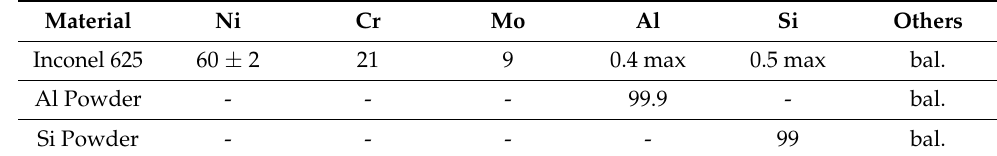
Table 1. Chemical composition of Inconel 625 superalloy and metallic powders used in this study by weight percentile (%, provided by